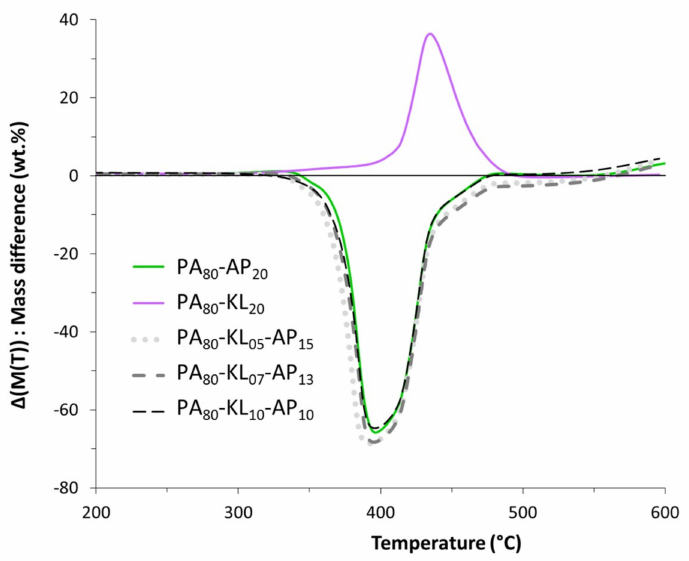
Figure 4. Curves of residual mass loss difference for PA blends with AP and